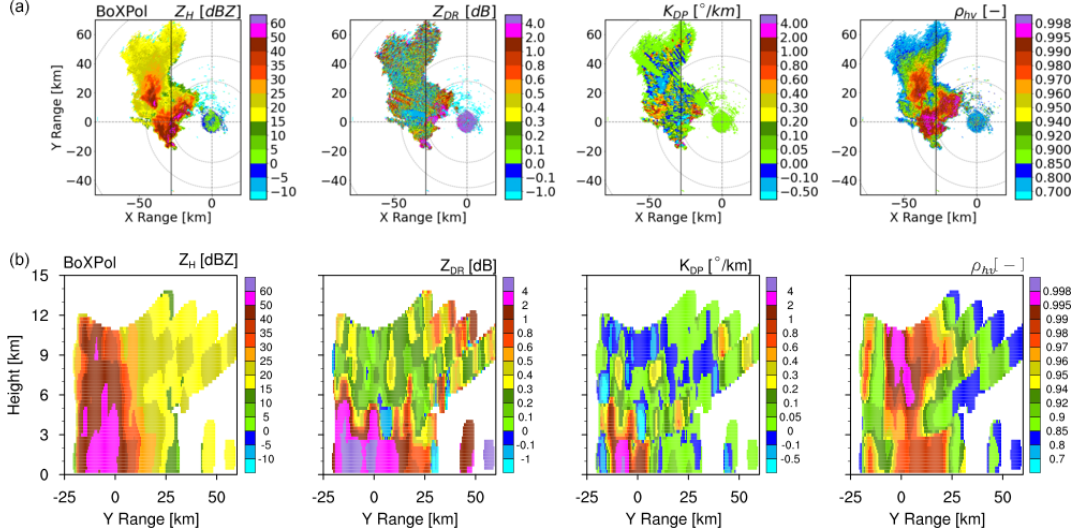
Figure 8. (a) Plan position indicator (PPI) plots of the horizontal reflectivity and differential reflectivity, specifically, the differential phase and cross-correlation coefficient at 8.2 ◦ elevation measured by BoXPol on 5 July 2015 at 15:30UTC. The dotted gray circles represent slant ranges for the chosen elevation angle, associated with heights of 1km (lower level), 4.5km (melting level), and 7km (upper level). (b) Cross section of the same polarimetric variables from the gridded data. The vertical solid black line along the Y range in panel (a) indicates the location of the cross-sectioned